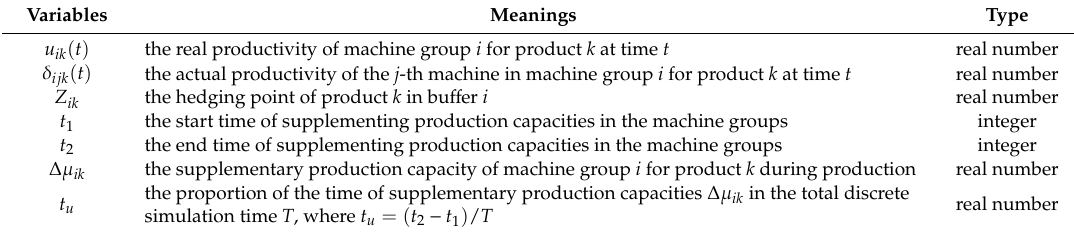
Table 3. The decision variables in the manufacturing